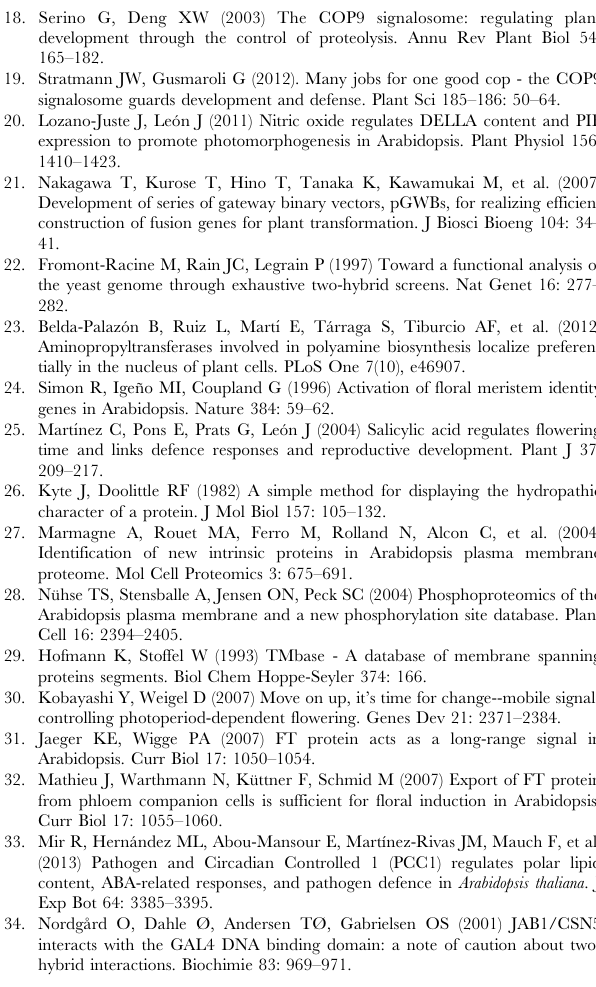
Figure S4 Hypocotyl length of Col-0 wild type and iPCC1 seedlings grown under white light or darkness. Values are the mean of 20 hypocotyls per genotype 6 SD. * and ** represents statistically significant (p , 0.05 or p , 0.01, respec- tively, in Students t-test) different values in iPCC1 or phyB seedlings when compared to wild type seedlings under the same condition. No statistically significant differences were observed following Students t-test for the seedlings grown under darkness. Table S1 Comparative transcript levels of phytochrome (PHY) and cryptochrome (CRY) encoding genes in iPCC1 vs Col-0